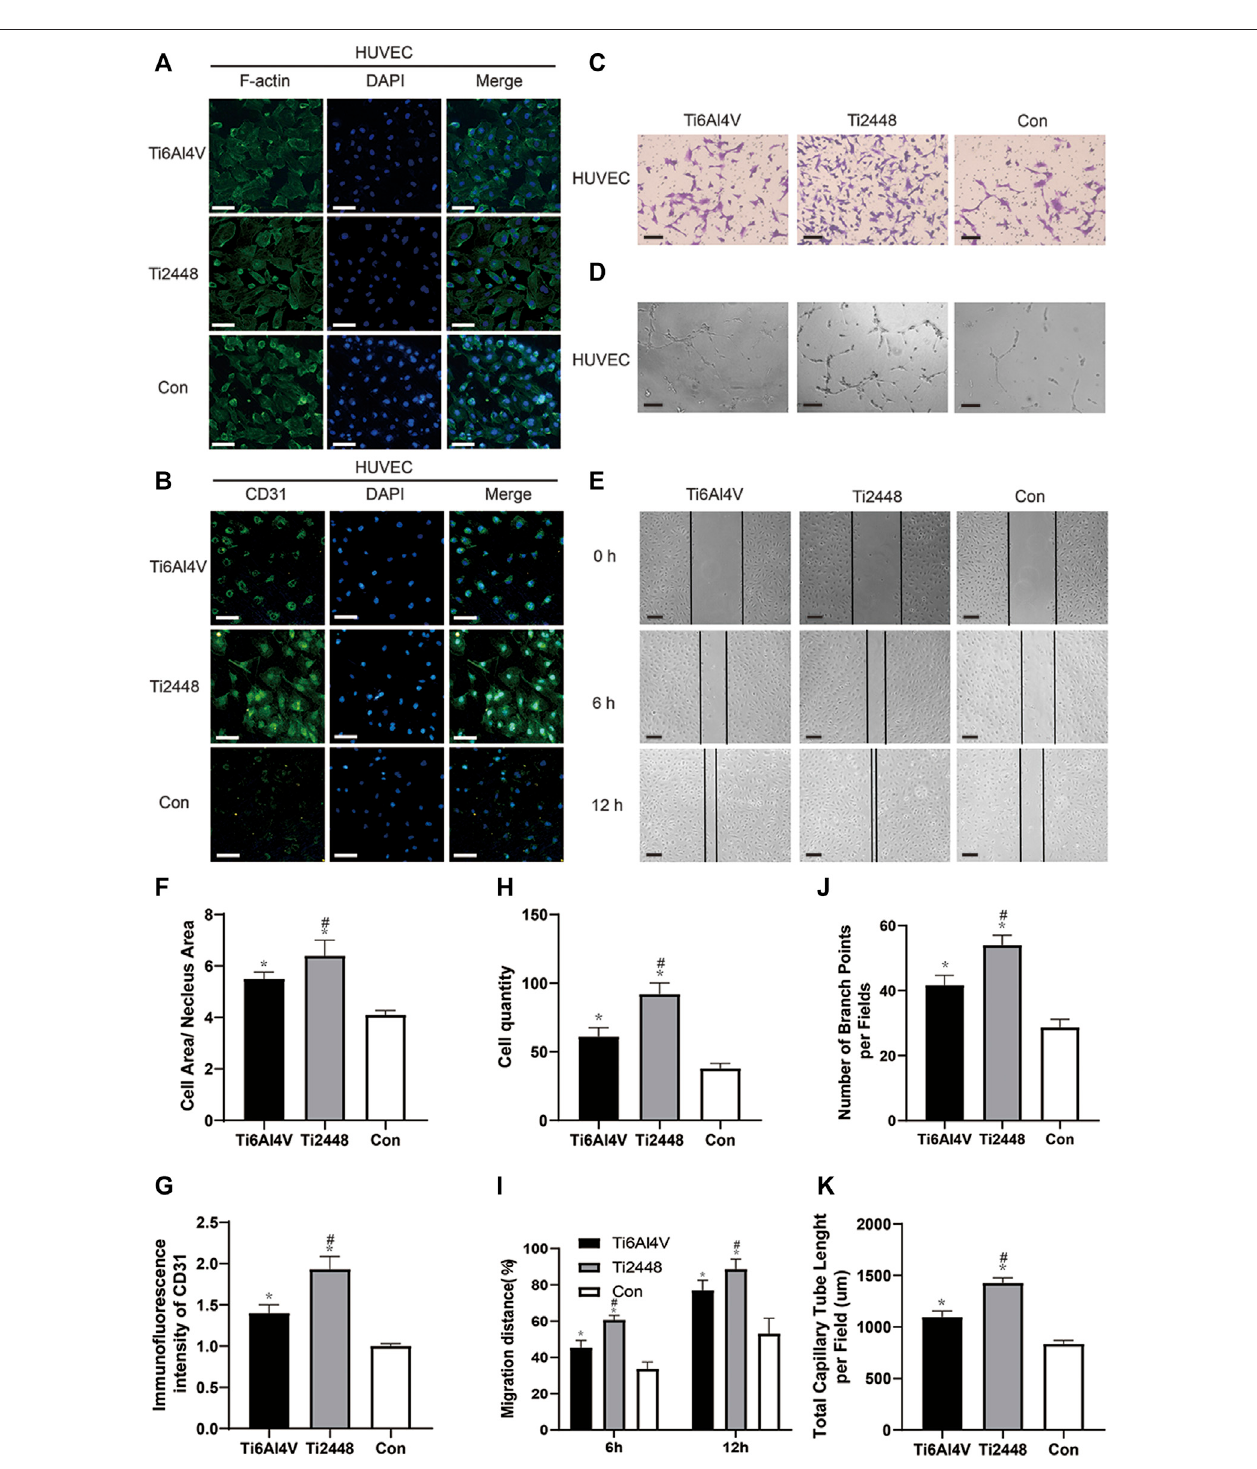
FIGURE 9 | Effects of different scaffolds on the angiogenic effect on HUVECs by regulating the polarization of macrophages. Immuno fl uorescence staining for examination of the cytoskeleton and expression of the angiogenic marker CD31 in HUVECs. Scale bar (cid:2) 100 µm (A,B) . Representative images of the invasion, tubule formation and migration assays. Scale bar (cid:2) 200 µm (C – E) . Quantitative analysis of the cell area/nuclear area in different groups (F) . Quantitative analysis of the fl uorescenceintensityofCD31indifferentgroups (G) .Quantitativeanalysisofthecellquantityindifferentgroups (H) .Quantitativeanalysisofthemigrationdistance indifferentgroups (I) .Quantitativeanalysisofthenumberofbranchpointsper fi eldindifferentgroups (J) .Quantitativeanalysisofthetotalcapillarytubelengthper fi eldin different groups (K) . Note: * p ＜ 0.05 compared to the control; # p ＜ 0.05 compared to Ti2448.